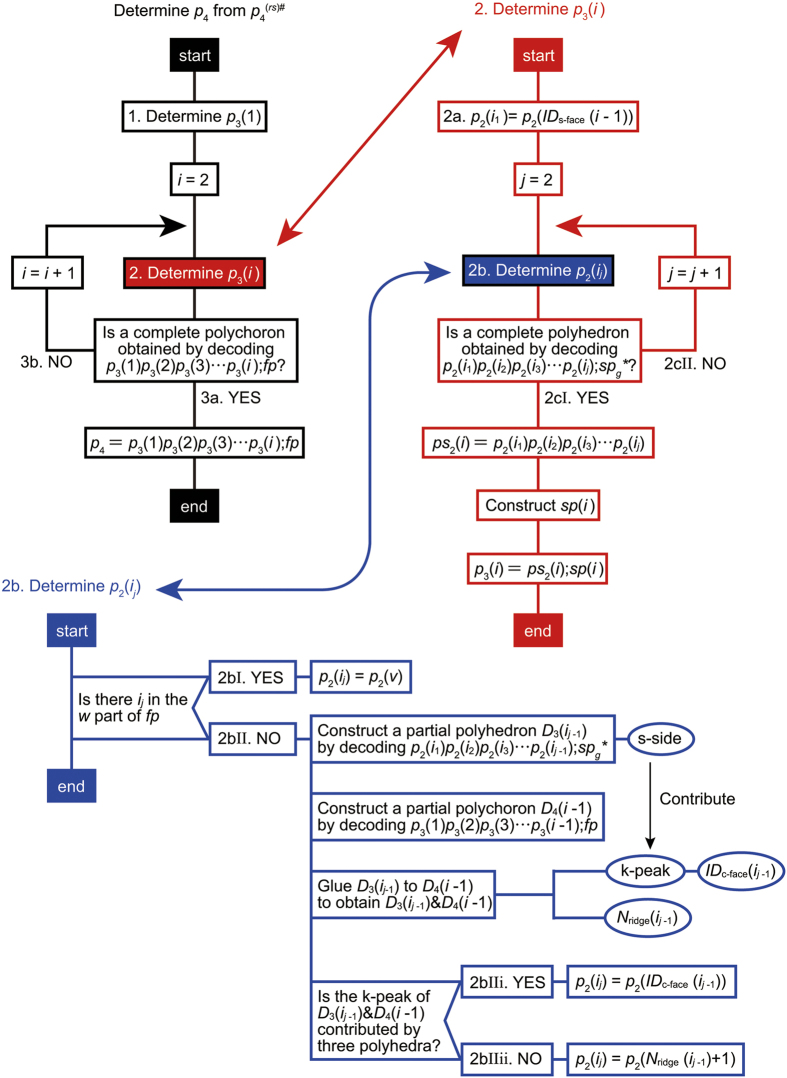
Procedures for recovering p4 from .